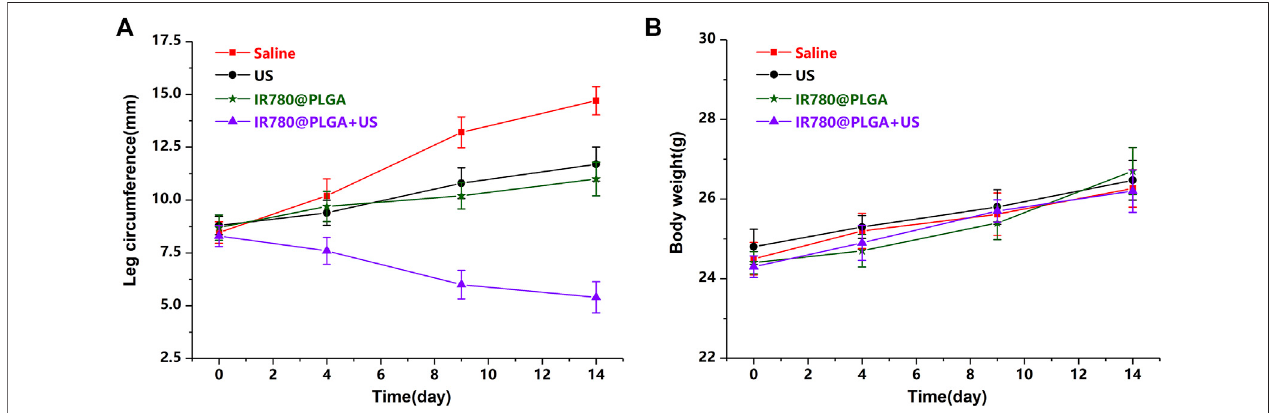
FIGURE 7 | (A) Average leg circumference curve measured by US and (B) average body weights of mice after different treatments (* p <